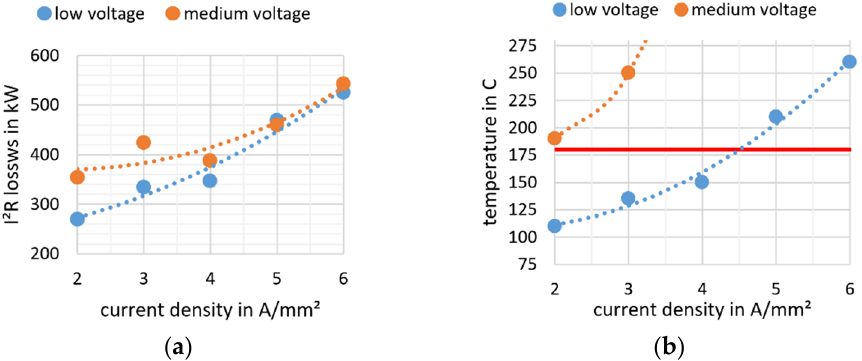
Figure 12. ( a ) I 2 R losses at 120 degree winding temperature in the stator winding; ( b ) Thermal be- havior of the winding respecting the losses.